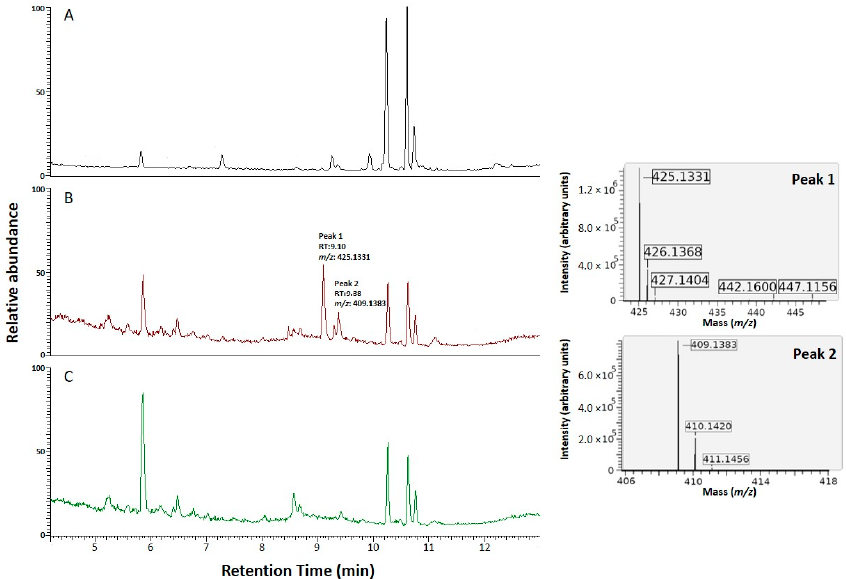
Figure 4. HPLC-MS analysis of extracts from 6-days-old MM 1% maltose cultures of A. niger strains. ( A ) Total ion chromatogram (TIC) of the parent strain CSFG_7003; ( B ) TIC of the mutant NRRL3_00042 OE strain, corresponding masses and adducts under peak 1 and peak 2 are shown on the right; ( C ) TIC of the mutant NRRL3_00042 OE _ NRRL3_00036 strain.